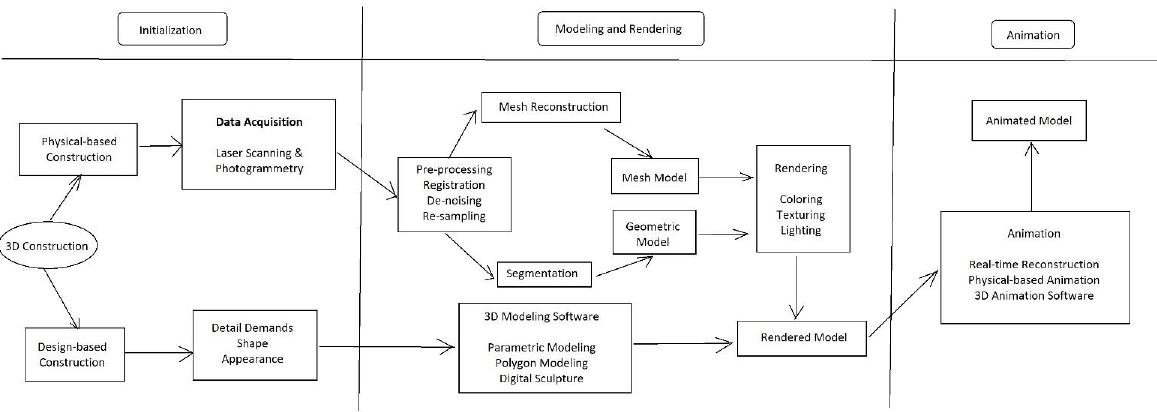
Figure 2. Visualization Construction Pipeline (courtesy of [45]).